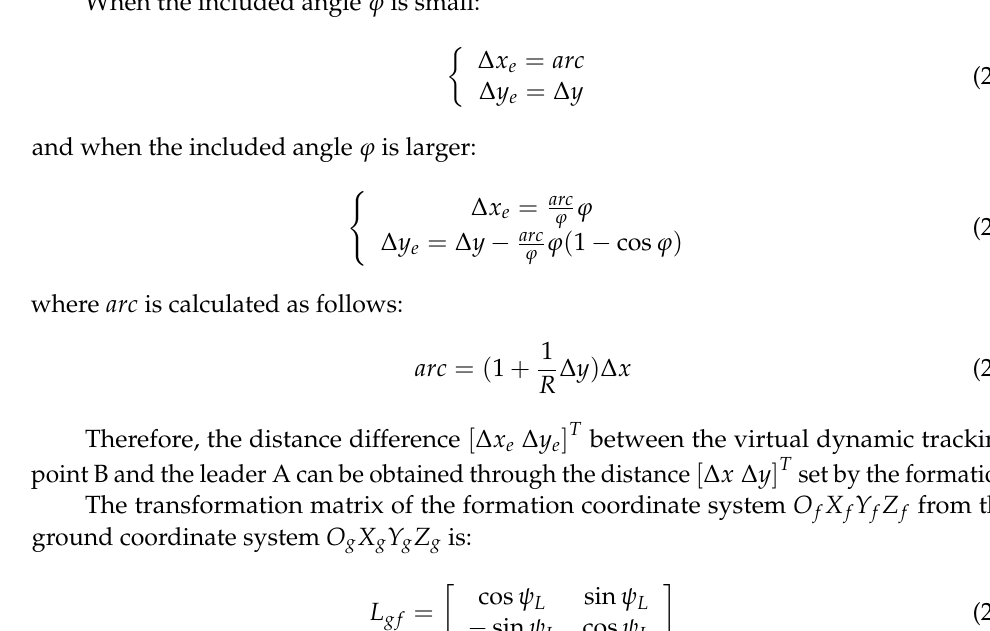
Figure 9. Virtual dynamic tracking point calculation. The formation coordinate system O f X f Y f Z f is fixed around the leader aircraft L , with the origin O f placed at the leader’s center of mass [19]. The O f X f axis points forward along the speed vector direction of the leader aircraft; the O f Y f axis is perpendicular to the O f X f axis and points to the right of the flight direction; the O f Z f axis is perpendicular to the O f X f Y f axis and points downward. In the two-dimensional scene, the coordinates of the horizontal virtual dynamic tracking point B are calculated on the plane O f X f Y f . The region between points A and B is shown in Figure 9. Points B and A lie on concentric circles with arc lengths of arc and ∆ x , respectively, ∆ y is the straight-line length between the circles, and R L is the flight radius of the lead aircraft. In this coordinate system, the coordinate difference between points B and A is ∆ x e and ∆ y e . Through the geometric relationship, the lengths of ∆ x e and ∆ y e can be